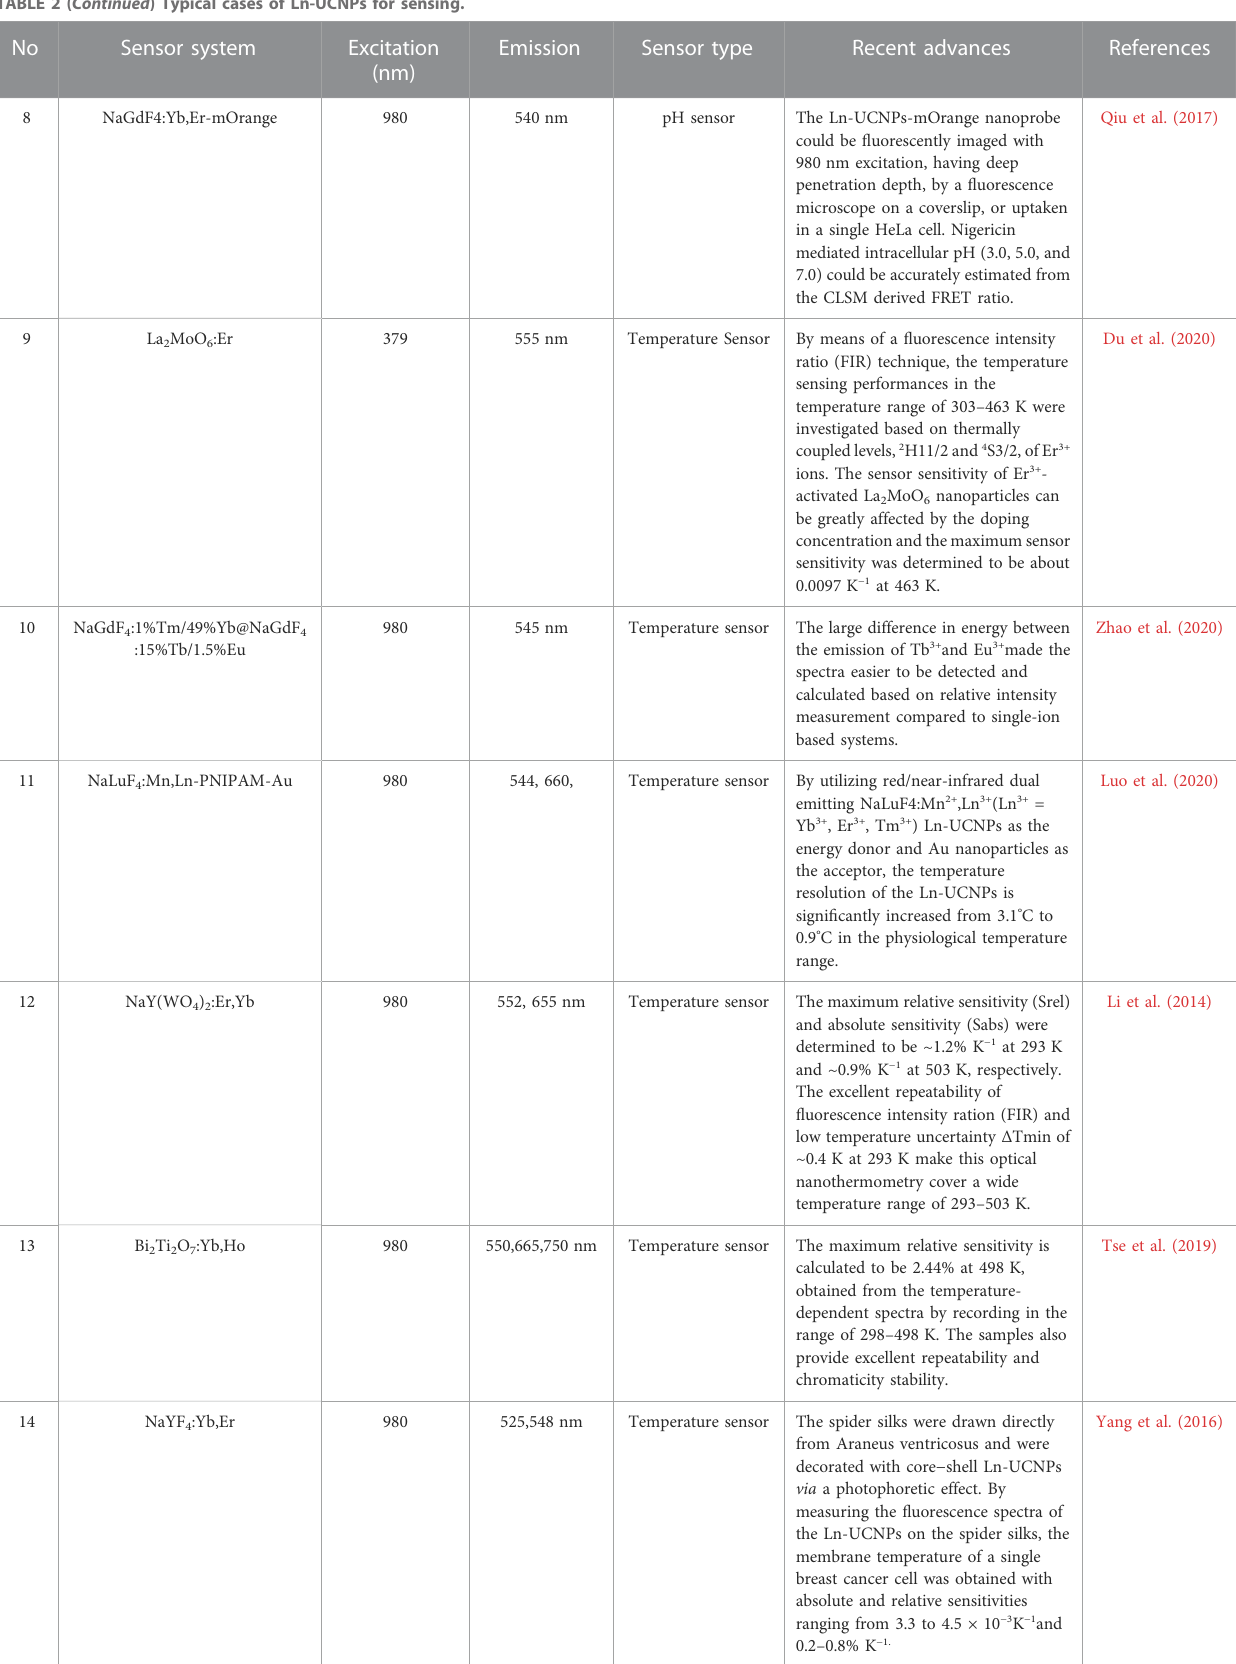
TABLE 2 ( Continued ) Typical cases of Ln-UCNPs for